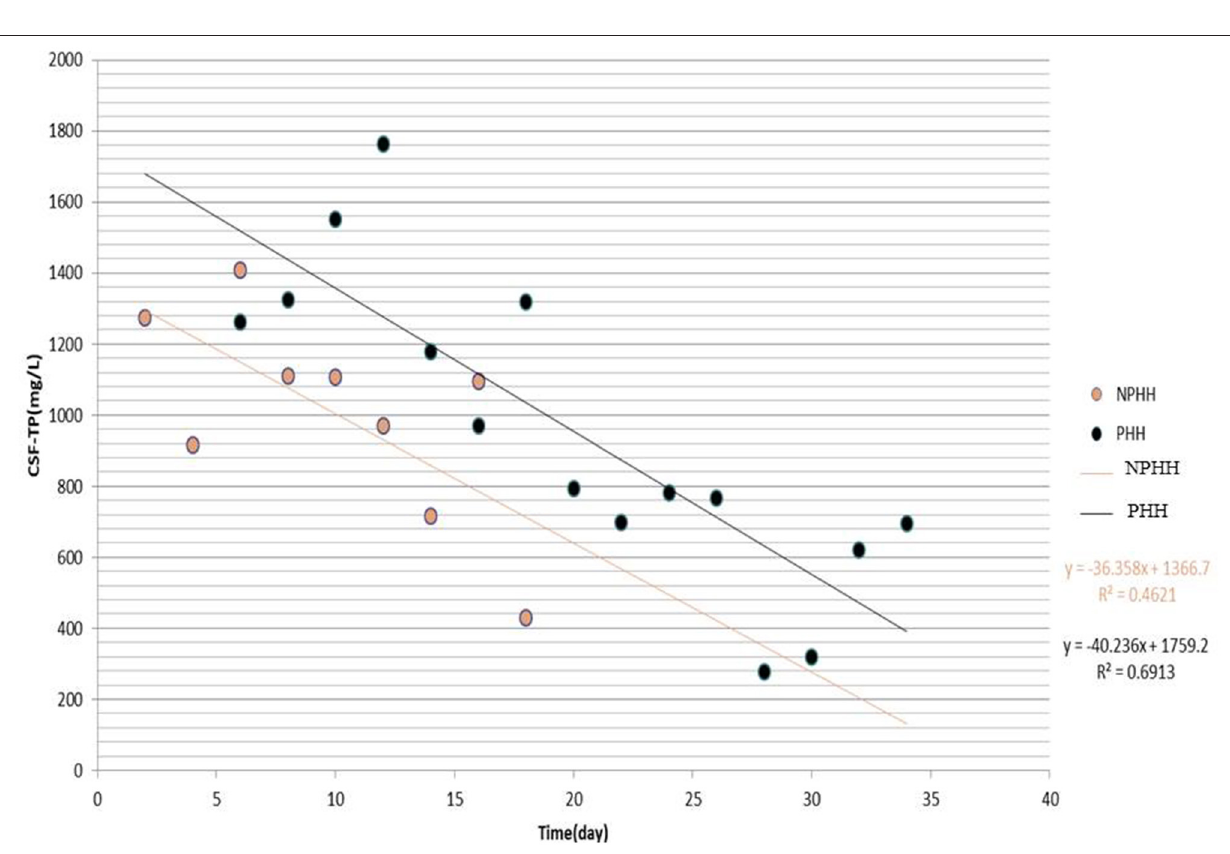
Frontiers in Surgery |